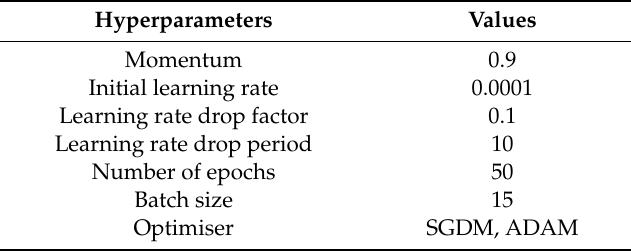
Table 3. Hyperparameter settings for the trained AlexNet model.